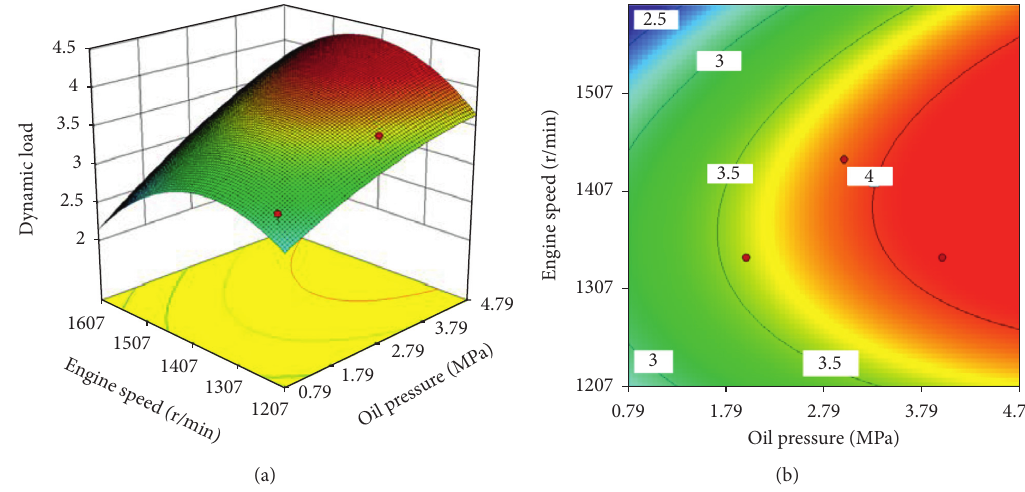
Figure 6: Response surface diagram and contour map of oil pressure and engine speed on interaction of dynamic load.